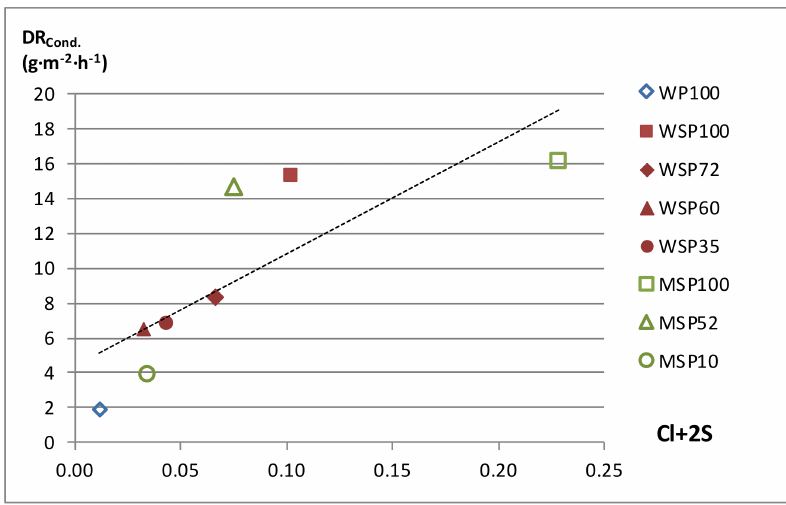
Figure 9. Deposition rate by inertial impact versus Sr